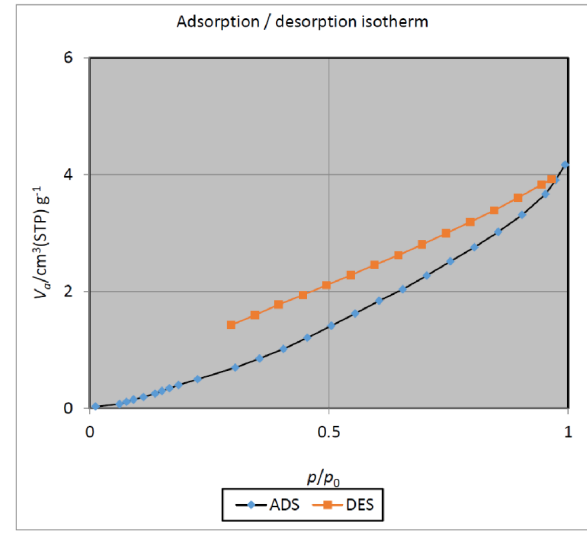
adsorption-desorption isotherm for the CuFe 2